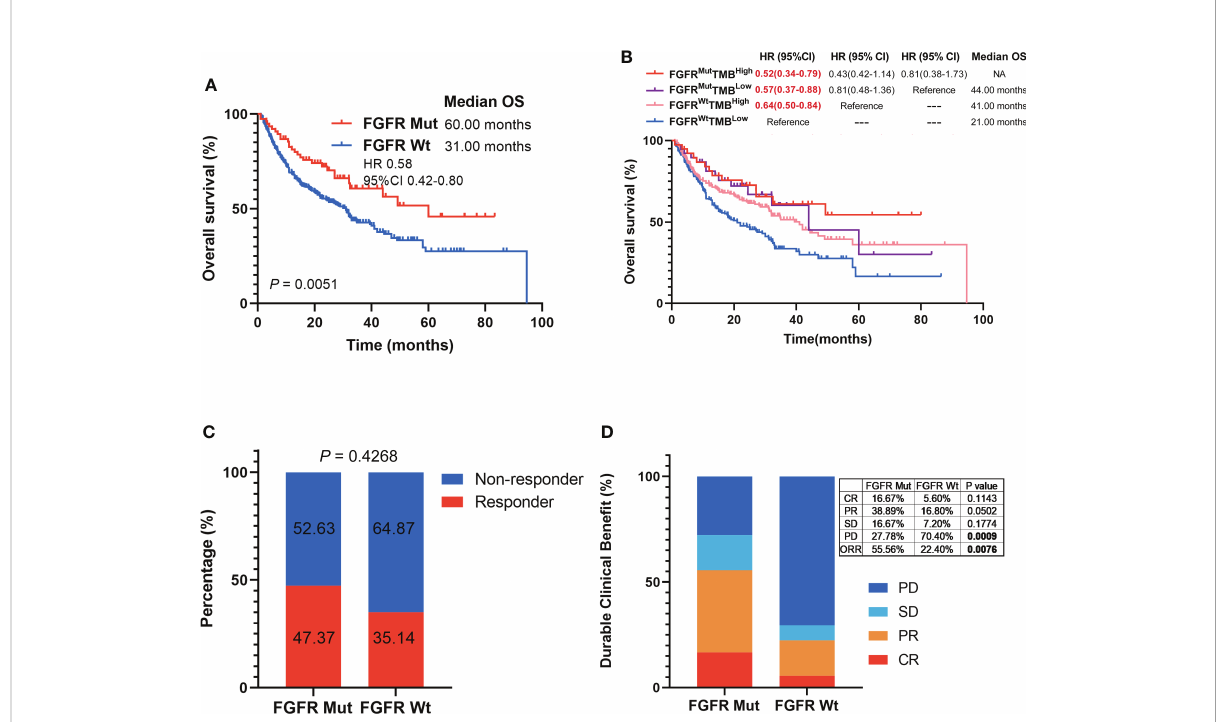
FIGURE 3 Association of FGFR mutations with melanoma clinical outcomes in ICIs-cohort. (A) The Kaplan-Meier survival analysis comparing OS between FGFR Mut and FGFR Wt patients in ICIs-cohort. (B) The Kaplan-Meier survival analyses comparing OS among FGFRMutTMBhigh, FGFRMutTMBlow, FGFRWtTMBhigh and FGFRWtTMBlow subgroups in ICIs-cohort. (C) Proportion of responders to ICIs in melanoma patients with FGFR mutations versus FGFR wild-type. (D) Comparison of the proportion of patients with complete response (CR), partial response (PR), stable disease (SD) and progression disease (PD) between FGFR Mut and FGFR Wt melanoma in ICIs-cohort.